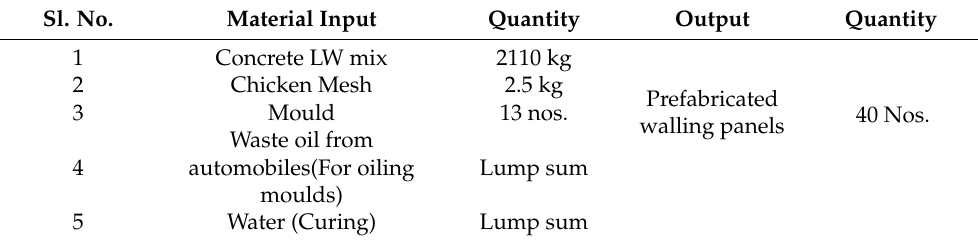
Table 8. Inventory details of Phase E—Casting of prefabricated panels. Sl. No.